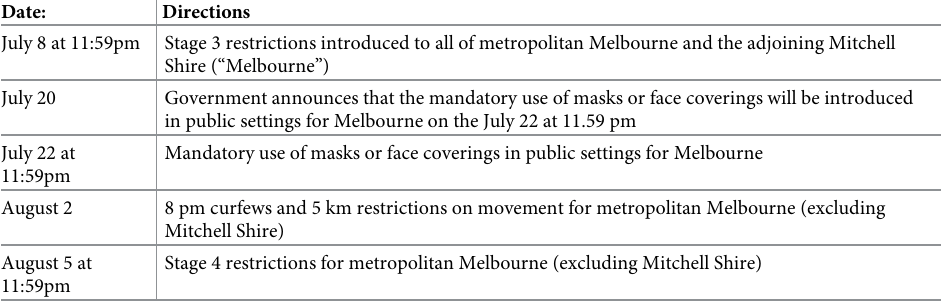
Table 1. Directions issued by Victoria’s chief health officer in Melbourne and Mitchell Shire in July and August 2020. Date: